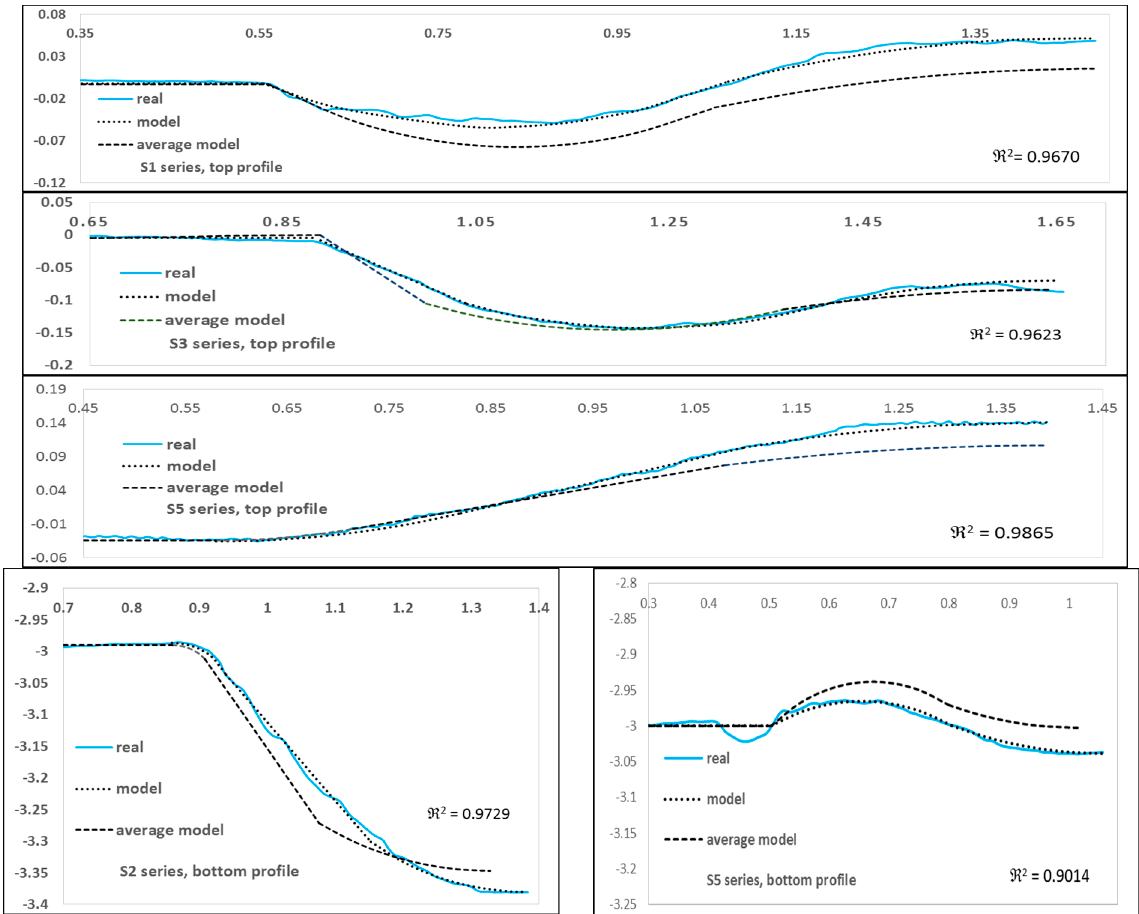
Figure 4. Examples of profiles: real, model and average model for S1, S2, S3 and S5 series (Y-axis and X-axis in mm).